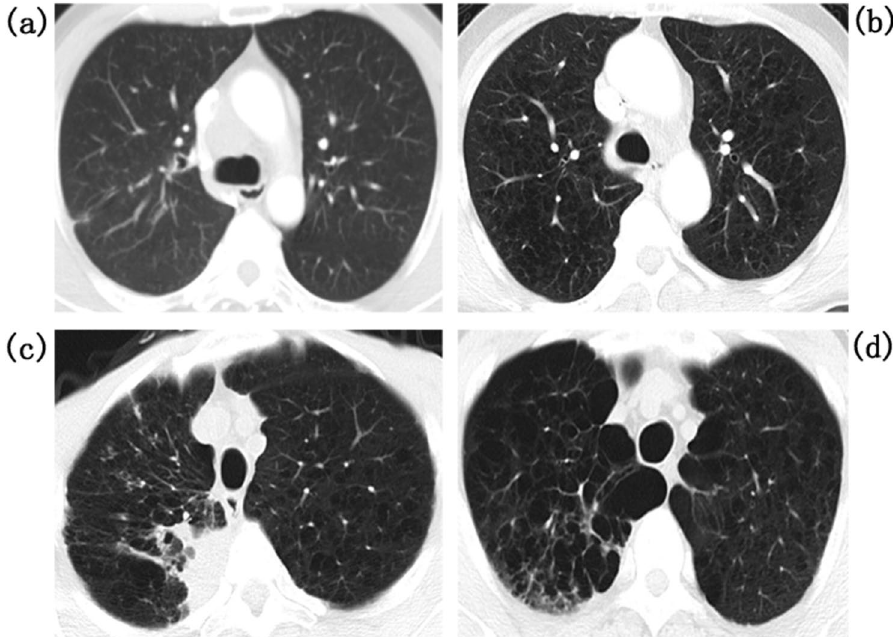
Figure 1. Pulmonary emphysema (PE) in computed tomographic (CT) images: ( a ) Grade 0, no low-attenuation areas (LAAs); ( b ) Grade 1, sparse and scattered small LAAs up to 5 mm in diameter; ( c ) Grade 2, adjacent LAAs up to 10 mm in diameter; ( d ) Grade 3, adjacent or indistinguishable LAAs > 10 mm in diameter.